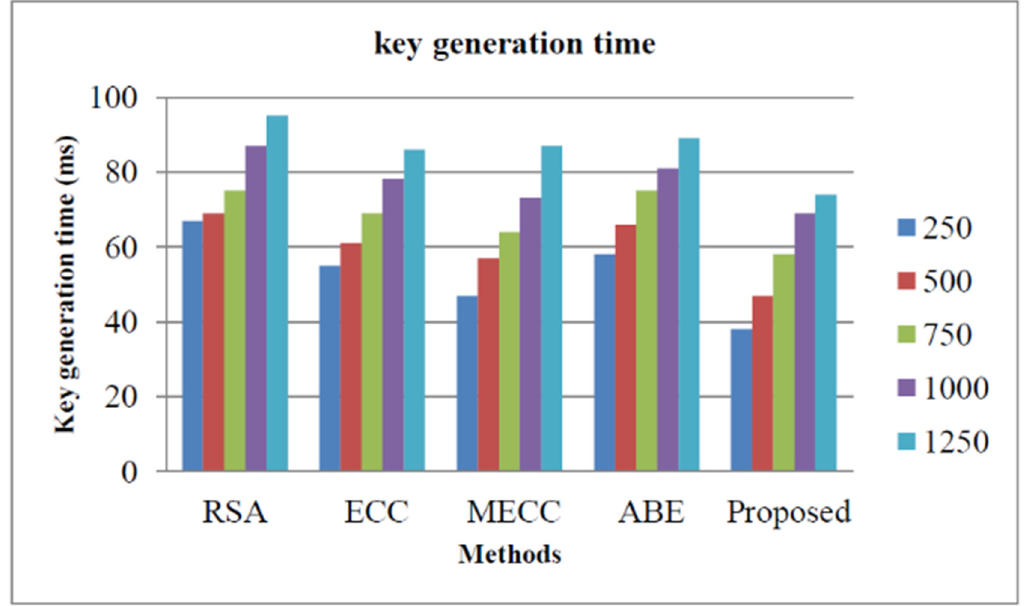
Figure 4. Storage security analysis based on key generation time.